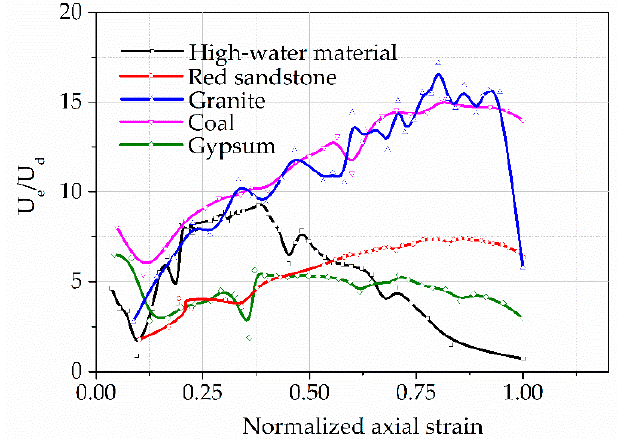
Figure 10. Evolution of the ratio of elastic strain energy to dissipated energy (